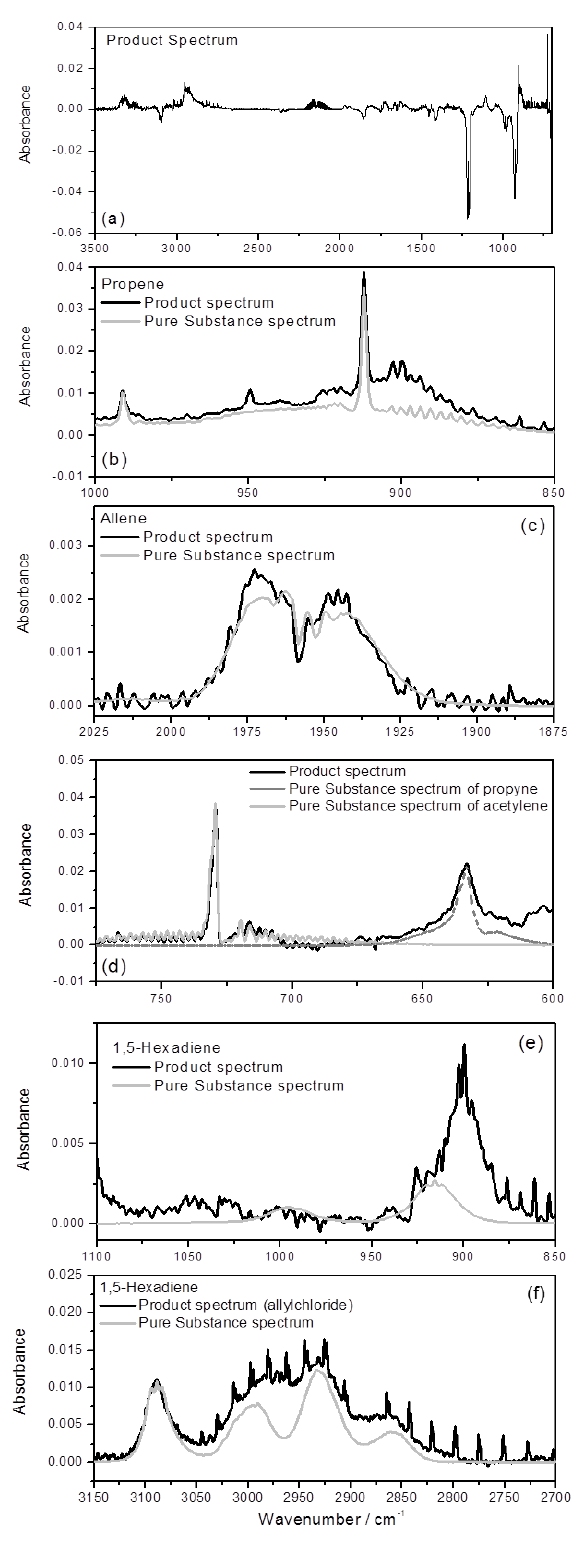
Figure 1. Product formation in the C identification of major products, ( a ) complete product spectrum, raw data ( b ) propene, ( c ) allene, ( d ) propyne and acetylene; ( e ) upper limit for 1,5-hexadiene; p(C ( f ) detection of CH = 4 mbar, bath gas Ar, T = 296 ± 1